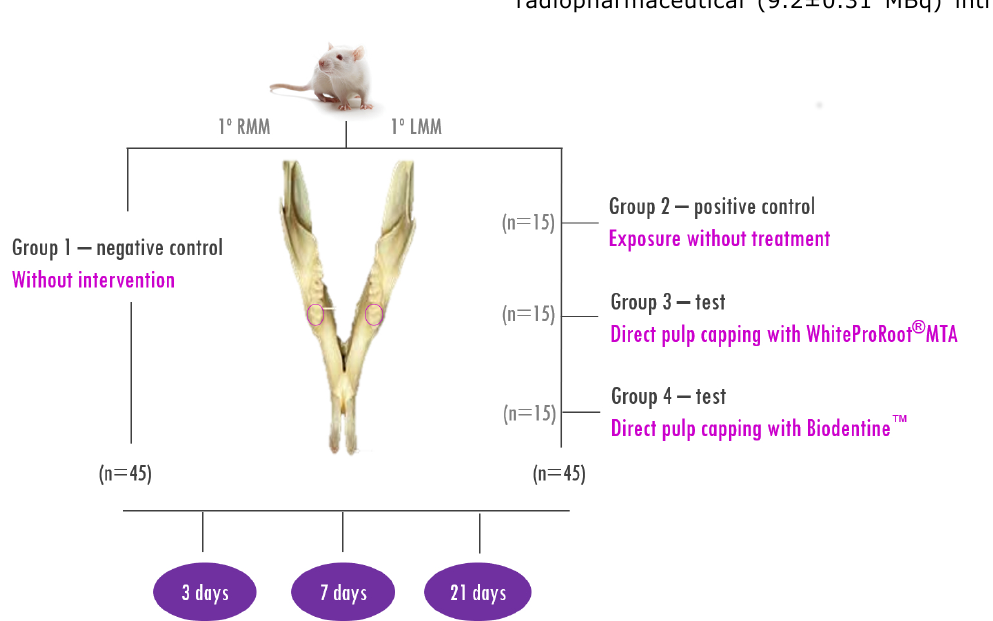
Figure 1- Split-mouth study design (RMM – right mandibular molar; LMM – left mandibular molar; no. – number of